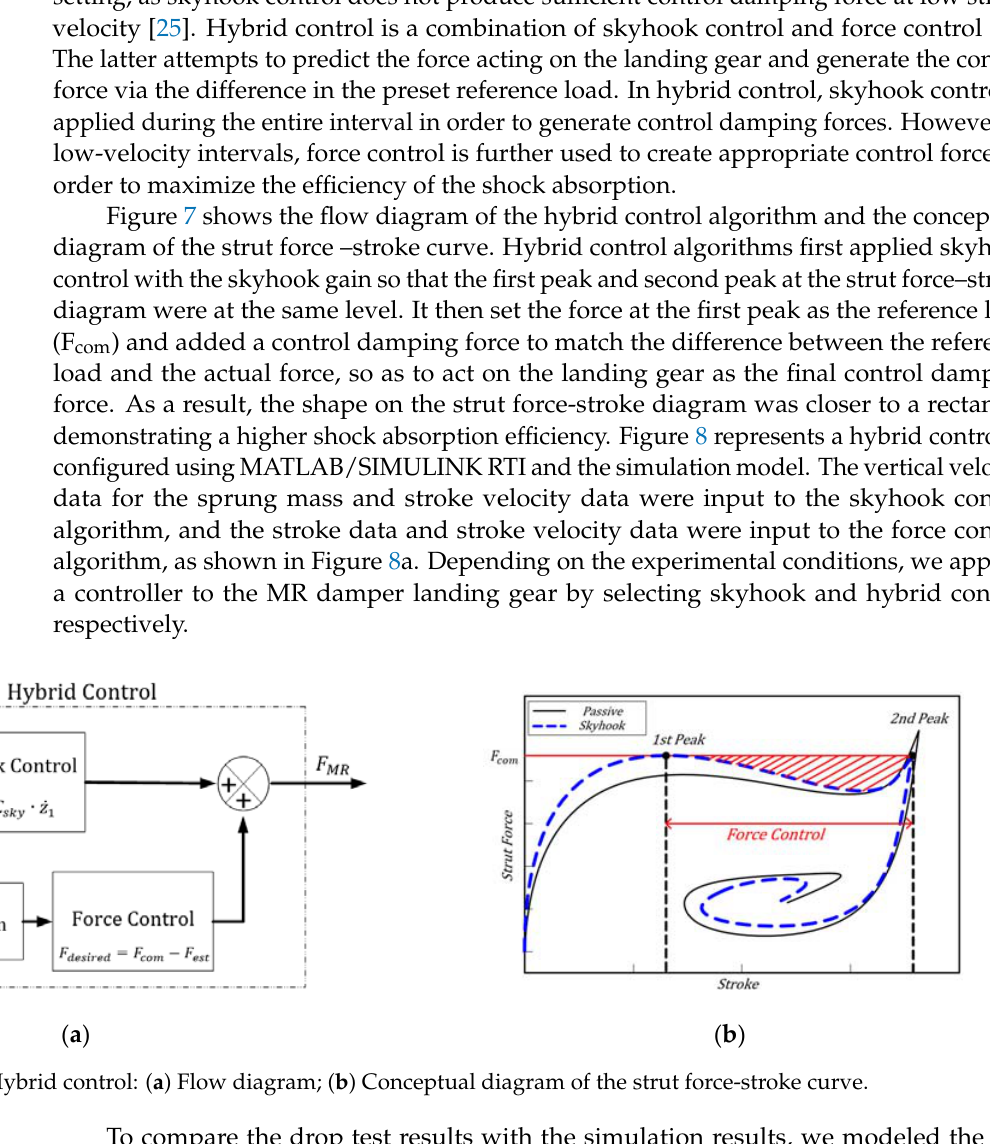
( a ) ( b ) Figure 8. MATLAB/Simulink diagram: ( a ) Hybrid controller with dSPACE; ( b ) Simulation model using Simpscape.